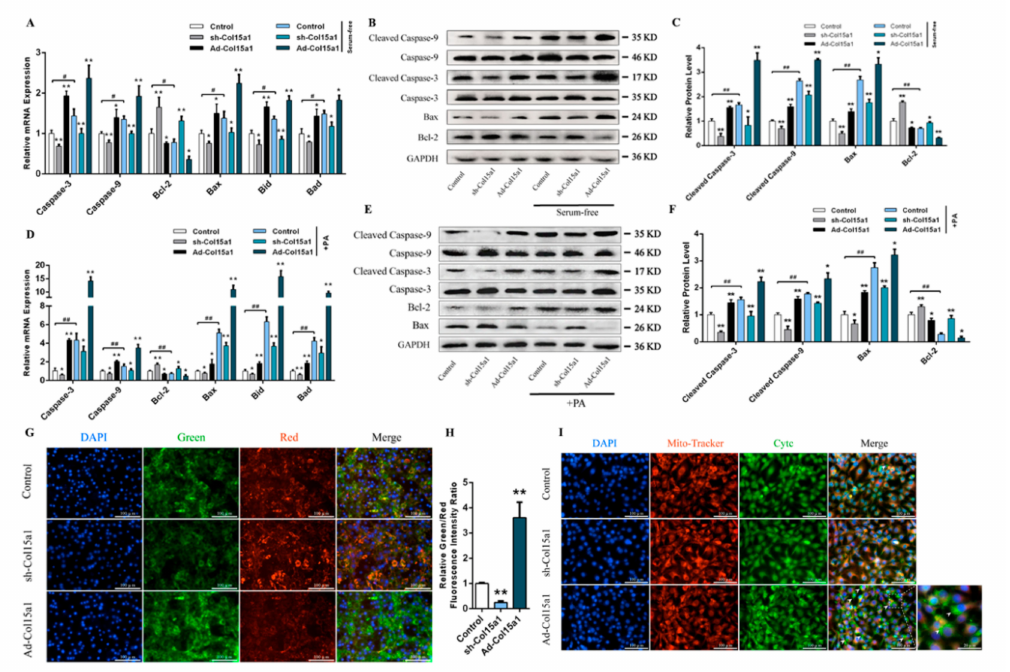
Figure 2. ColXV exacerbated apoptosis in unfavorable state adipocytes and involved a mitochondrial pathway. ( A – C ) Relative mRNA and protein expressions of Caspase-3 / Cleaved Caspase-3, Caspase-9 / Cleaved Caspase-9, Bax, Bcl-2, Bid, andBadinmiceadipocytesintheControlgroup,